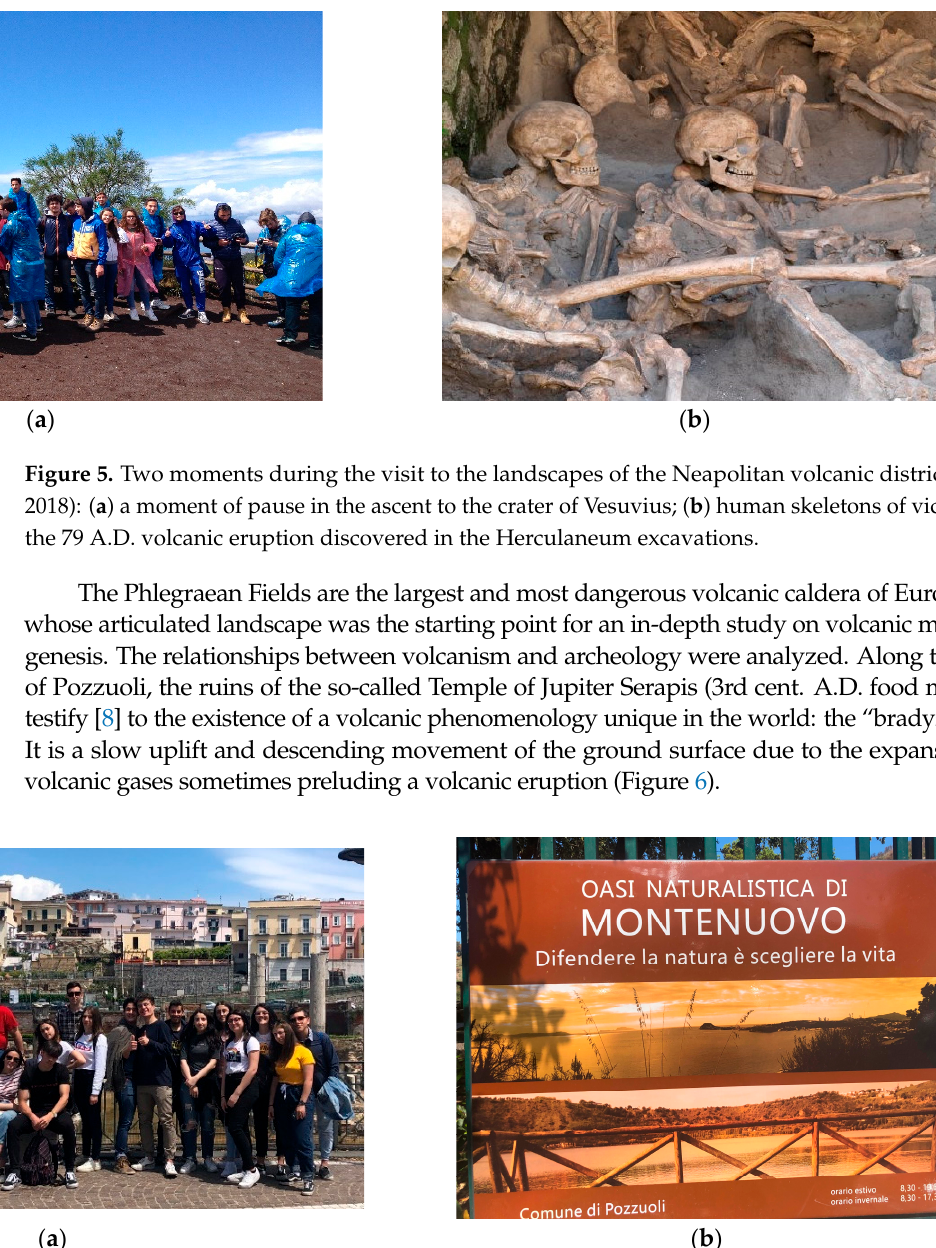
Figure 4. Knowledge of the hydrogeological behavior of karst springs: ( a ) visit to the karst area of the Grassano springs (San Salvatore Telesino, Benevento Province) (year 2017); ( b ) the upwelling groundwater flow in the Serino area (Serino, Avellino Province) (year 2017).